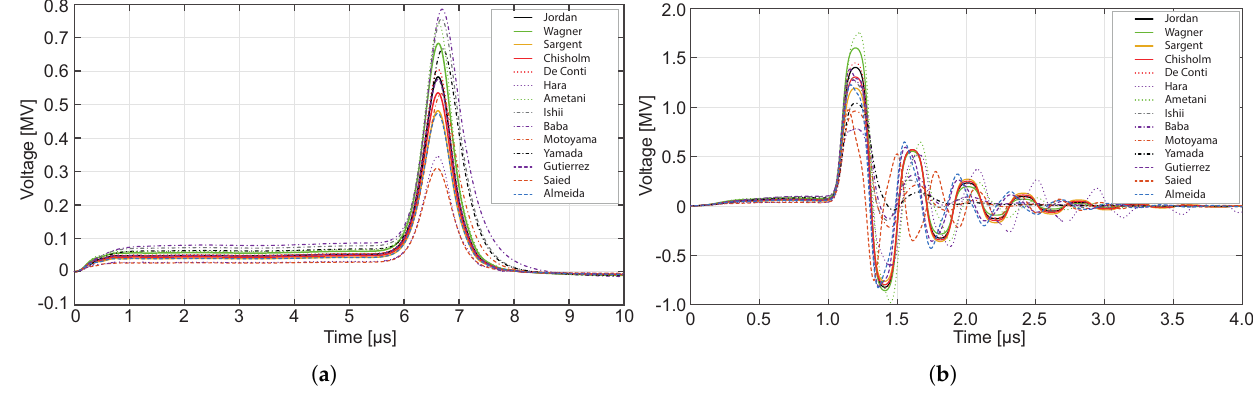
Figure 22. Voltage at the top of tower (a) over a PEC plane when the first and subsequent stroke currents in Figure 20 are injected. ( a ) Response to the first stroke current. ( b ) Response to the subsequent stroke current.